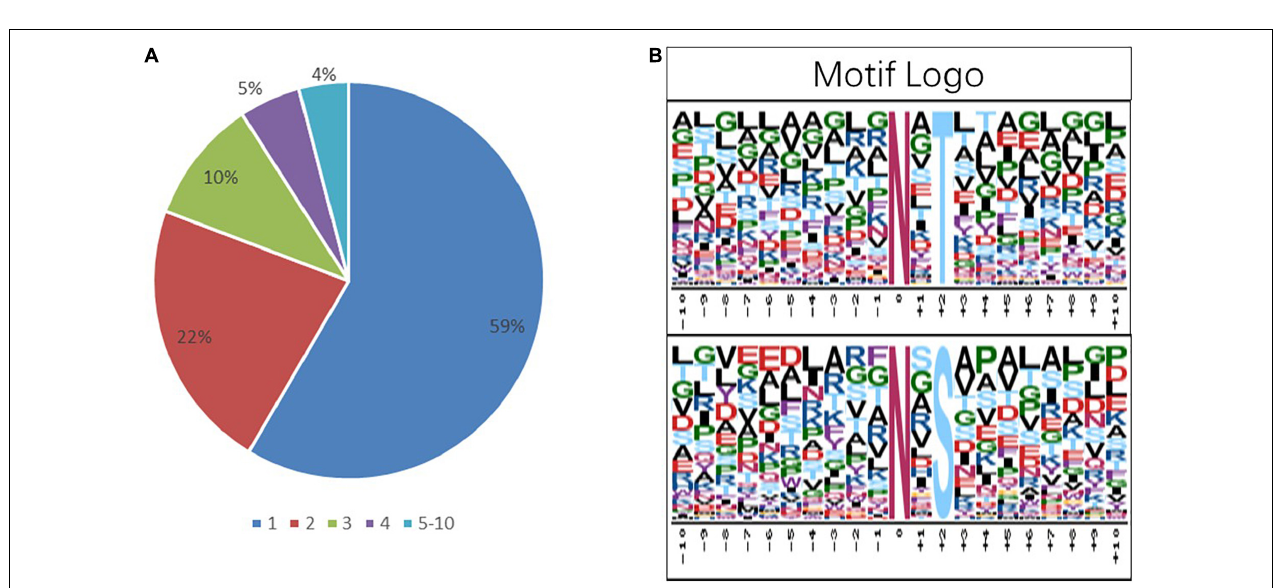
FIGURE 3 | The subcellular localization of C. thermophilum proteome and N-glycoproteome data. (A) The distribution of proteins and N-glycoproteins in subcellular locations. (B) Subcellular locations of differentially expressed proteins in T50/T30, T55/T30, and T55/T50. (C) Subcellular locations of differentially expressed N-glycoproteins in T50/T30, T55/T30, and T55/T50.